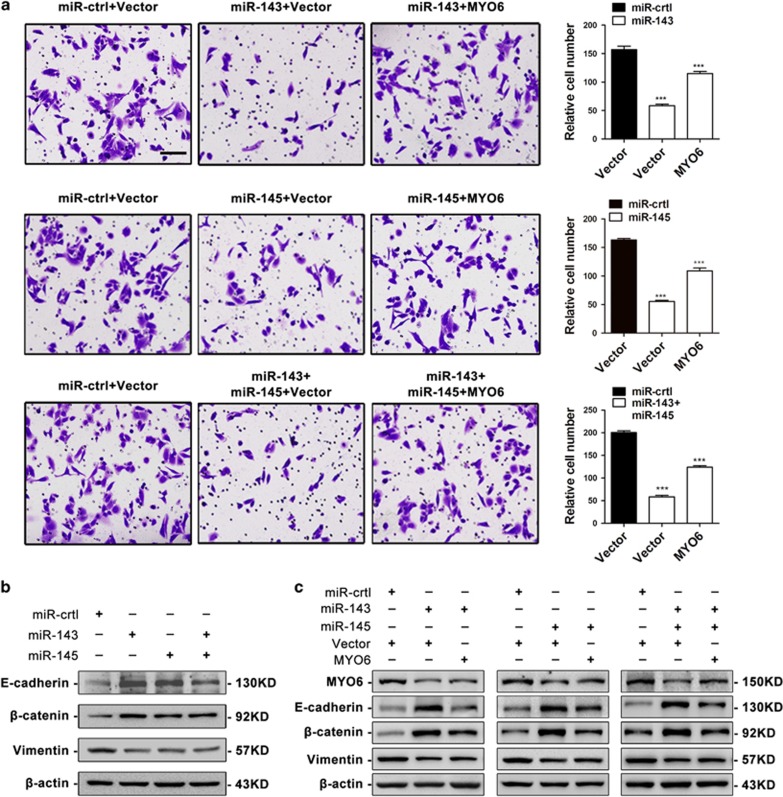
Restoration of MYO6 attenuates the suppressive effects of miR-143 and/or miR-145. (a) Transwell assays of BGC823 cells co-transfected with miR-143 and/or miR-145 mimics or miR-ctrl with either an empty vector or the MYO6 plasmid, scale bar: 100 μm. (b) EMT marker protein expression in BGC823 cells transfected with miR-143 and/or miR-145 mimics or miR-ctrl. (c) EMT marker protein expression in BGC823 cells co-transfected with miR-143 and/or miR-145 mimics or miR-ctrl with either an empty vector or the MYO6 plasmid. ***P<0.001